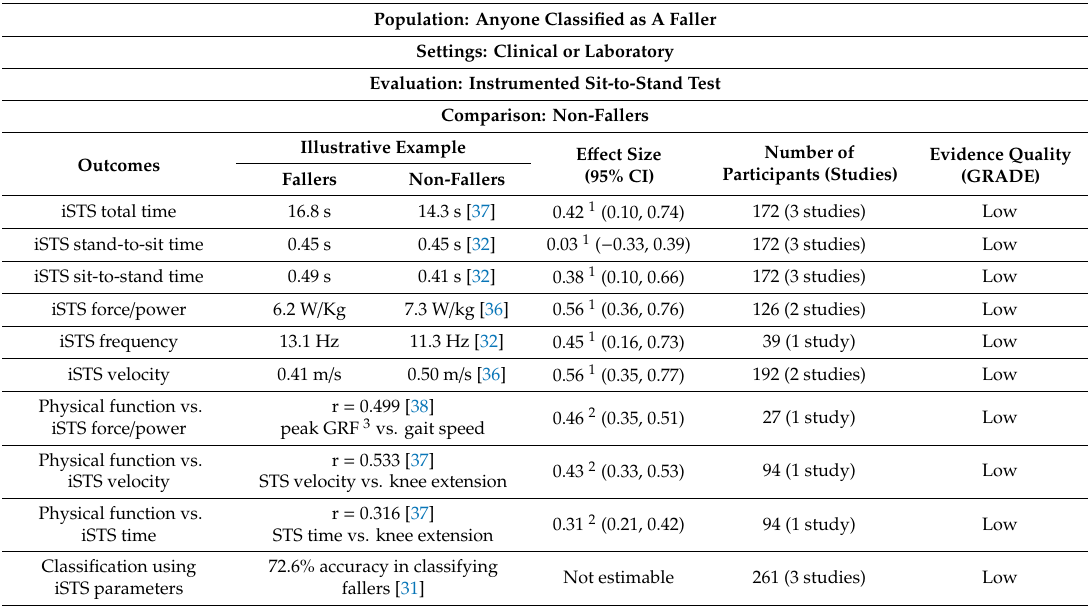
Table 3. Summary of findings for fallers vs.